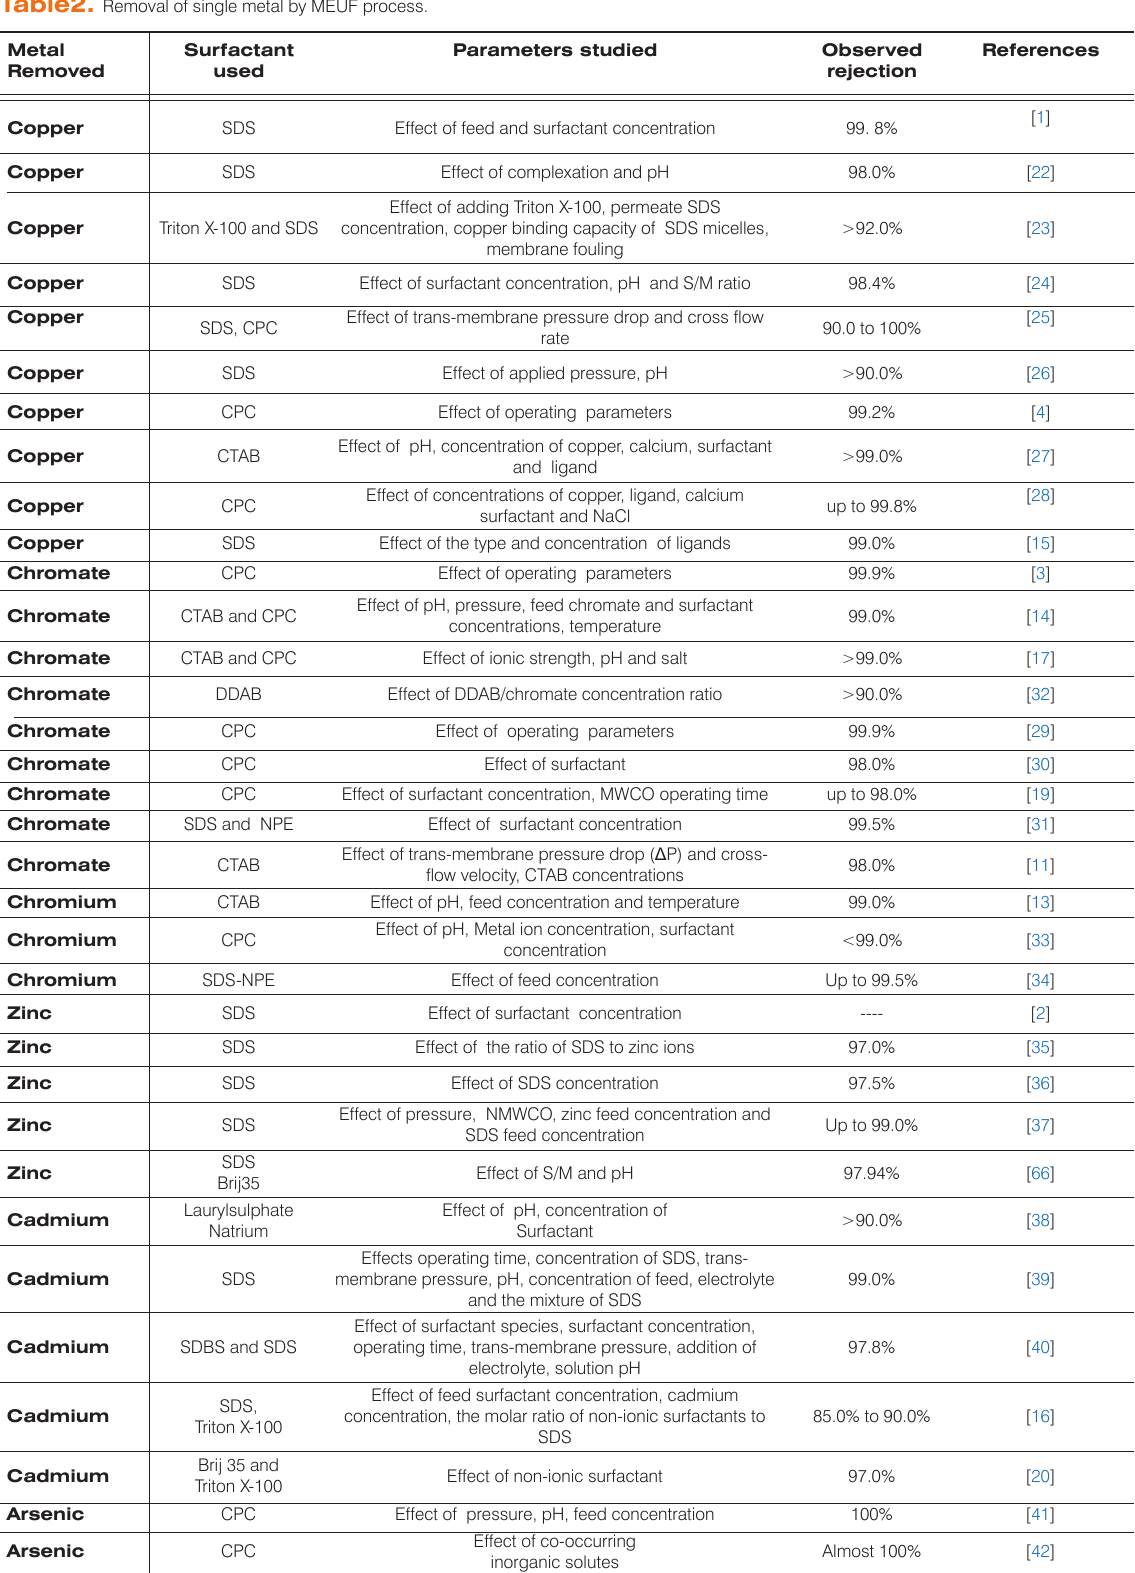
Table2. Removal of single metal by MEUF